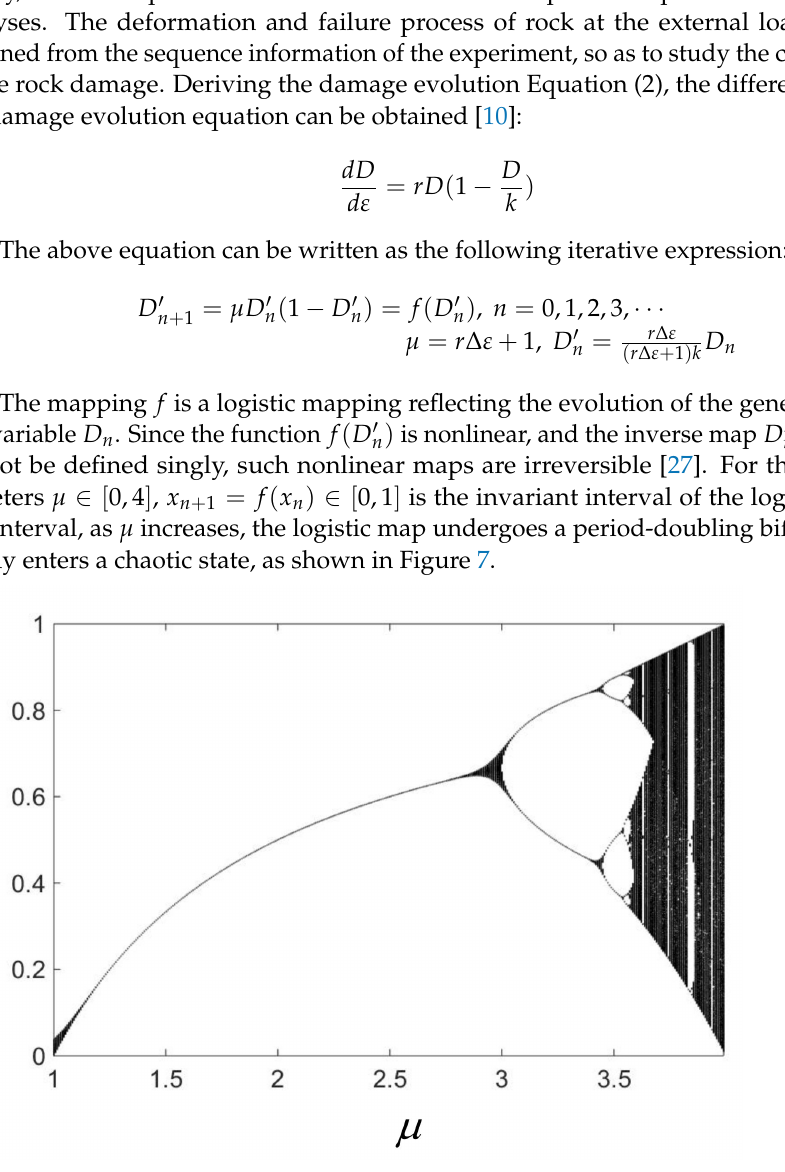
Figure 7. Solution graph of logistic